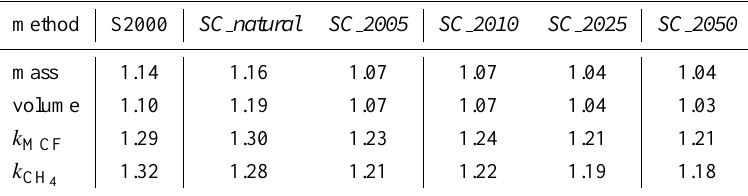
Table 4. Global average tropospheric OH concentration in 10 6 cm 3 , estimated with different weightings (mass, volume, methyl chloroform reaction and methane reaction) factors for the different simulations presented in this work. S2000 is the same calculation from the work of Spivakovsky et al.